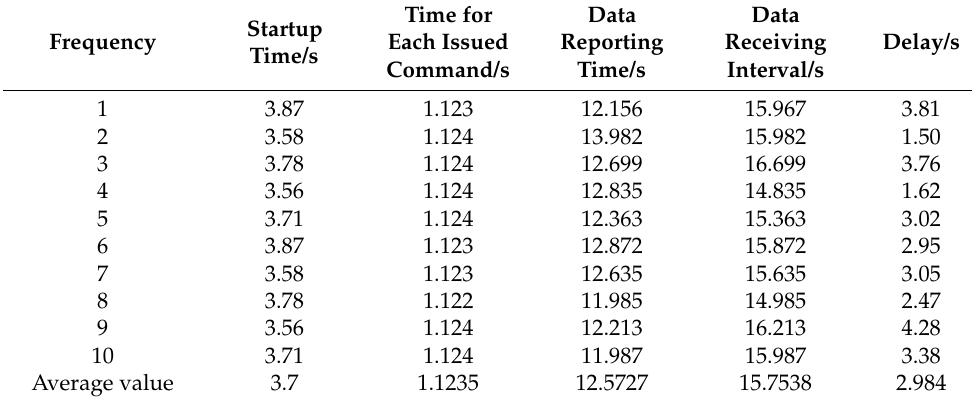
Table 6. Close-range test results (within 1 and 100